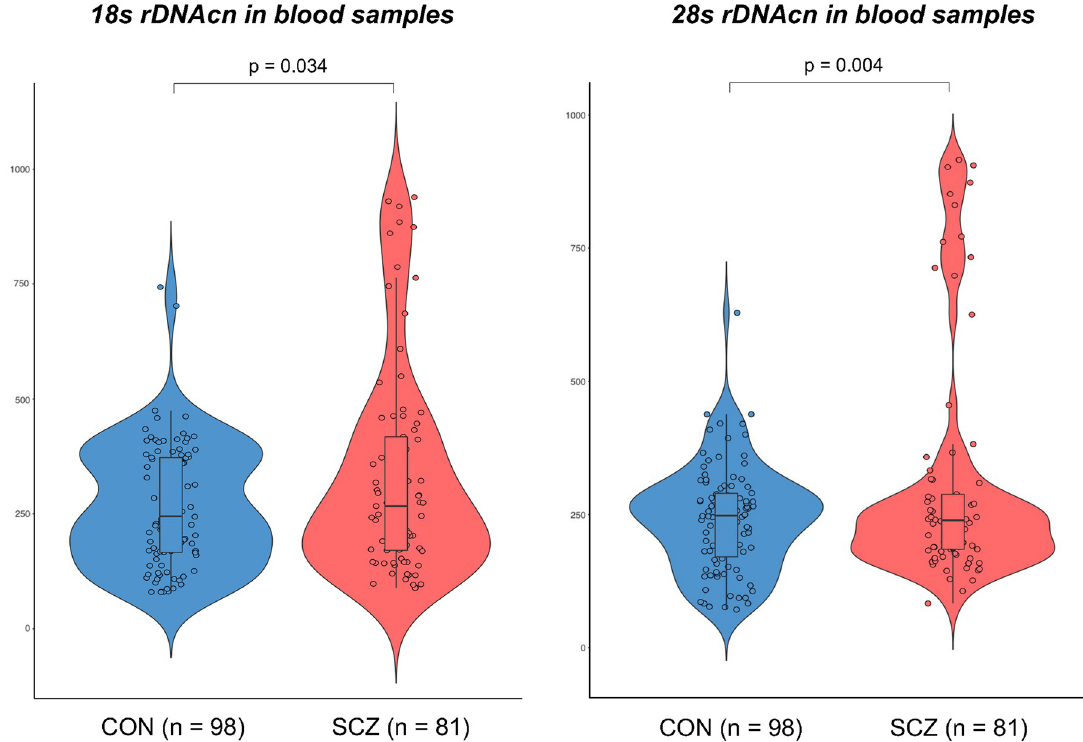
Fig 1. Violin and scatter dot plot including box and whiskers (with minimum to maximum) of 18S/28S ribosomal DNA copy number (rDNAcn) in blood samples from patients with schizophrenia (SCZ) and controls (CON). All p values were adjusted for age and sex as